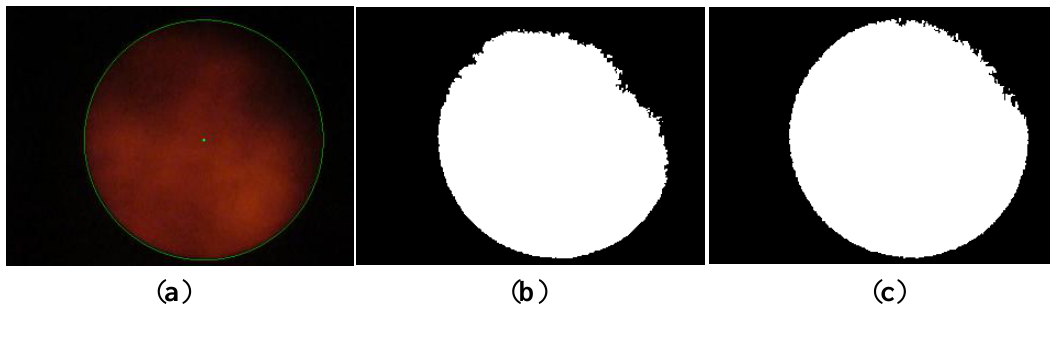
Figure 7. ( a ) Sun picture of sky with many clouds; ( b ) Binarization with L: 0.078~1.0; ( c ) Binarization with L: